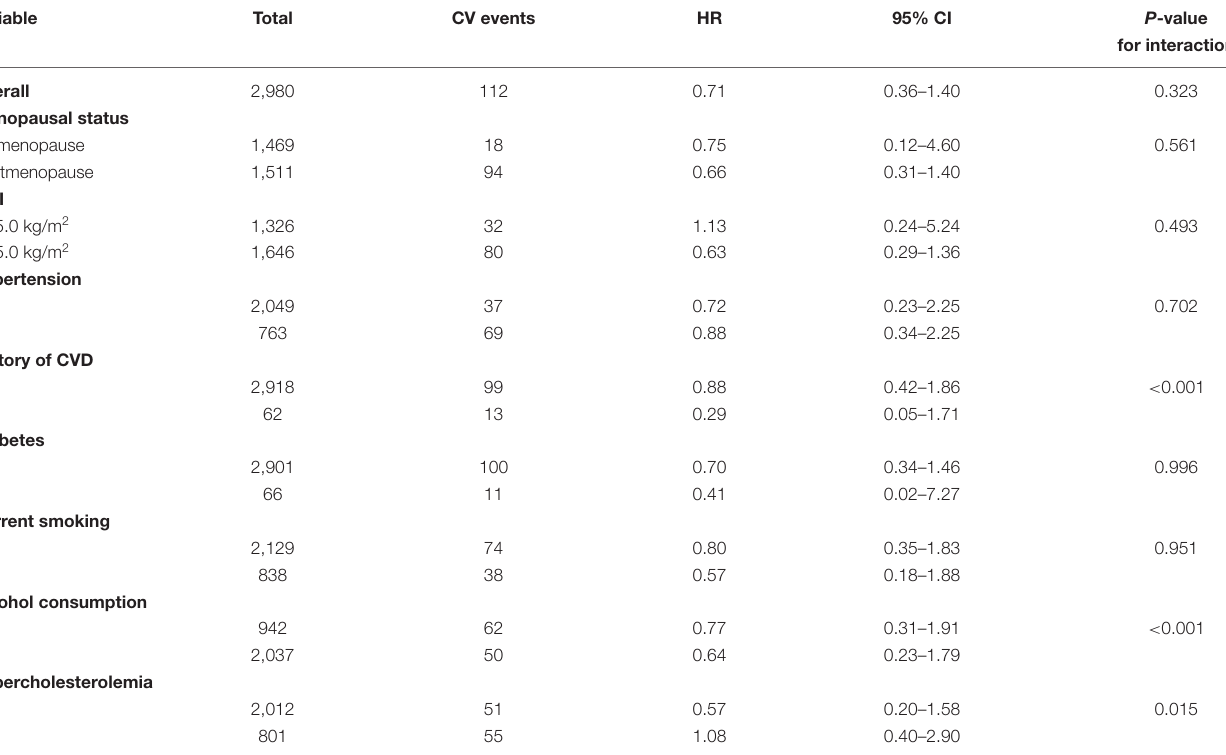
TABLE 5 | Stratified analyses for the association between 2 log-transformed serum free thiols and the risk of cardiovascular events across various subgroups.